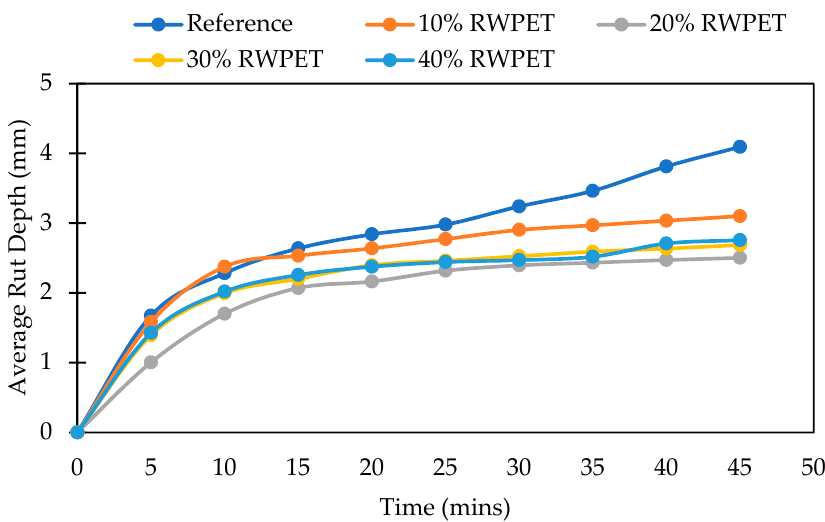
Figure 7. Average rut depth for RWPET modified mixtures at 45 °C.